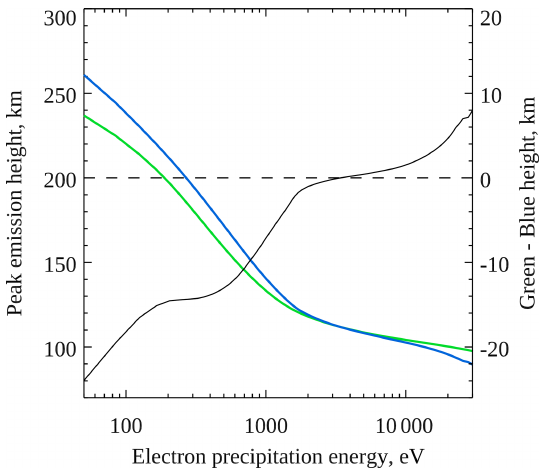
Figure 8. Peak emission heights of 557.7nm aurora (green) and 427.8nm aurora (blue) as a function of characteristic electron pre- cipitation energy for Maxwellian electron spectra, obtained using the Southampton ionospheric model. The difference in these heights is shown in black, using the right ordinate axis.